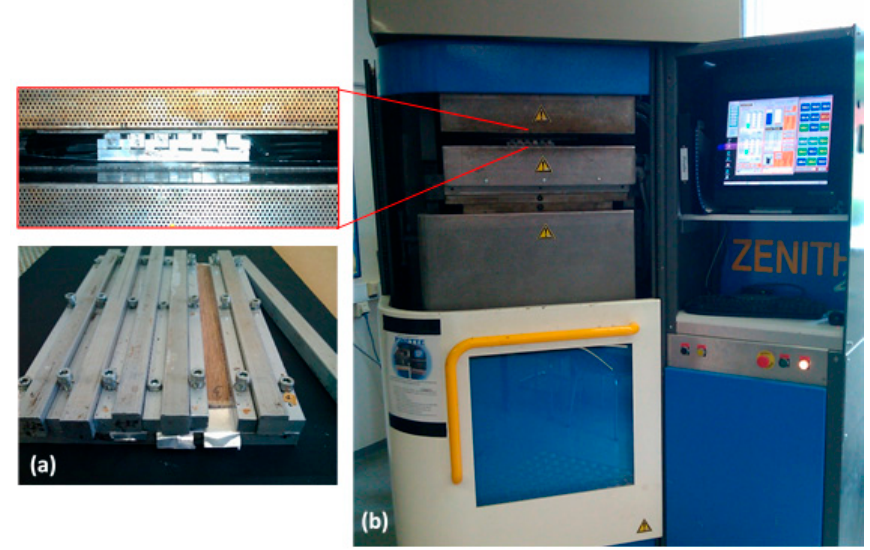
Figure 2. ( a ) Mold for tensile test samples, and ( b ) Composite processing in the Pinette hot